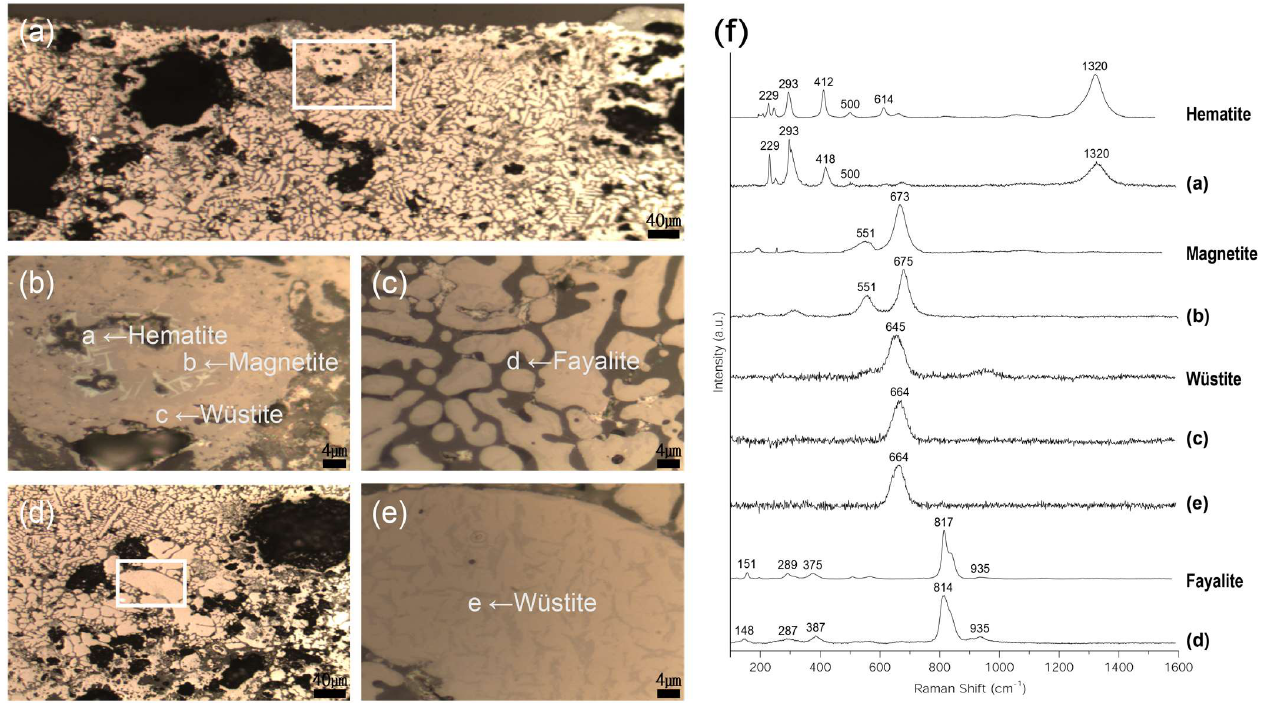
Figure 8. ( a – e ) Position of Raman micro-spectroscopy analysis of flake hammer scale (No. 2); ( a ) rectangle is position of ( b , c ), ( d ) rectangle is position of ( e ), ( f ) Raman spectrum. ( a ) rectangle is position of ( b , c ), ( d ) rectangle is position of ( e , f ) Raman